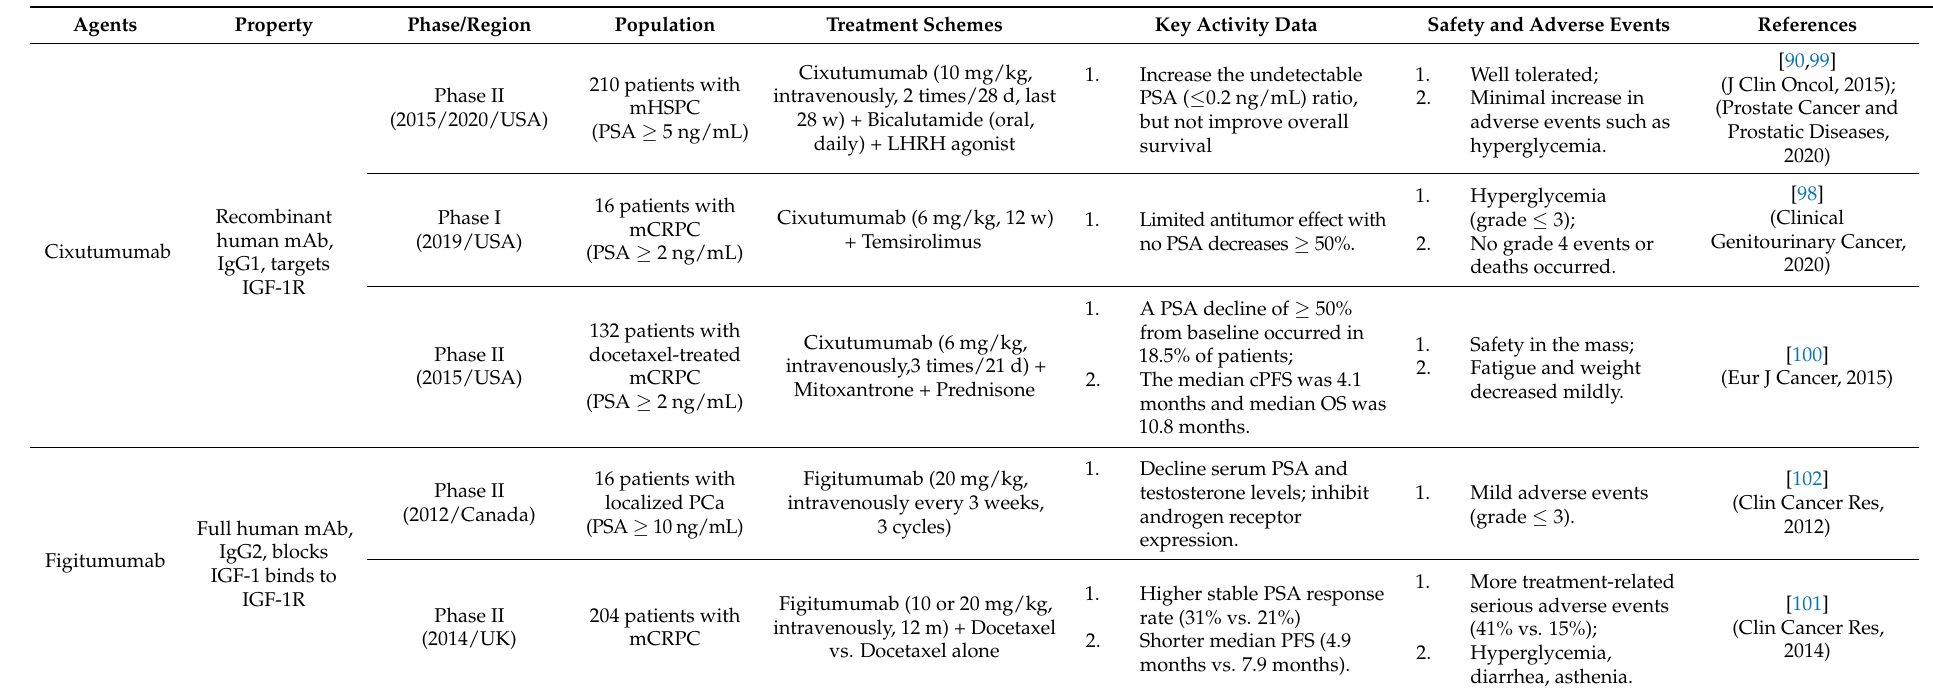
Table 2. Literature of IGF-1R inhibitors under clinical investigation in